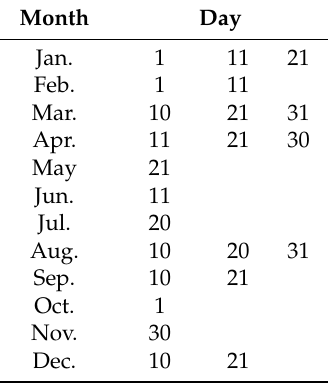
Table 2. A list of months and days on which the multimodel ensemble analysis was performed between 1999 and 2009.